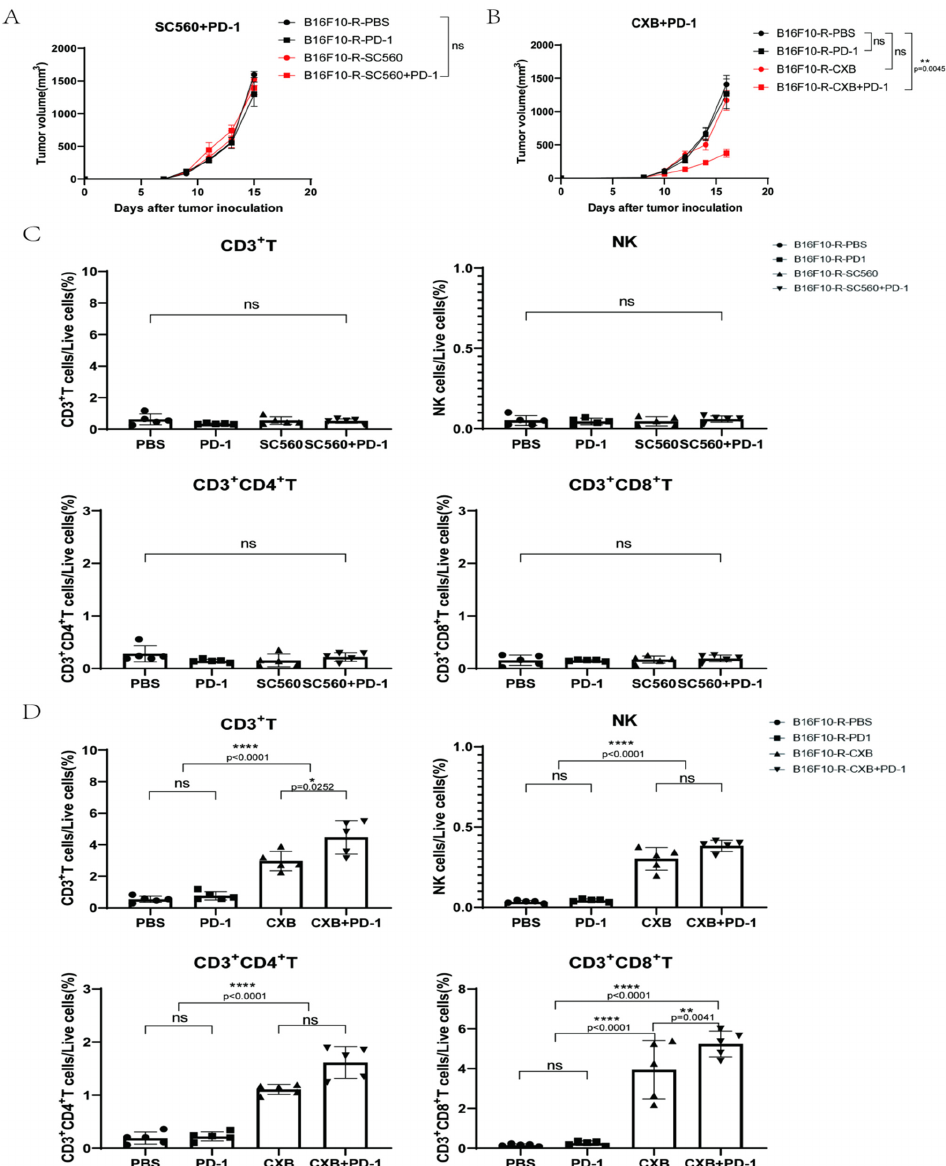
Figure 4. Effects of SC560 or celecoxib combined with pembrolizumab on B16F10-R tumour growth in vivo. ( A ) Growth curves of B16F10-R tumours in vivo treated with pembrolizumab, SC560, or PBS ( n = 6–8/group, two-way ANOVA test, Tukey). ( B ) Growth curves of B16F10-R tumours in vivo treated with pembrolizumab, celecoxib, or PBS ( n = 6–8/group, two-way ANOVA test, Tukey). ( C ) Differences in the number of infiltrating lymphocytes cells in B16F10-R tumours treated with celecoxib (one-way ANOVA test, Tukey). ( D ) Differences in the number of infiltrating lymphocytes in B16F10-R tumours treated with SC560 (one-way ANOVA test, Tukey); ns, not statistically significant; * p < 0.05; ** p < 0.01; **** p <